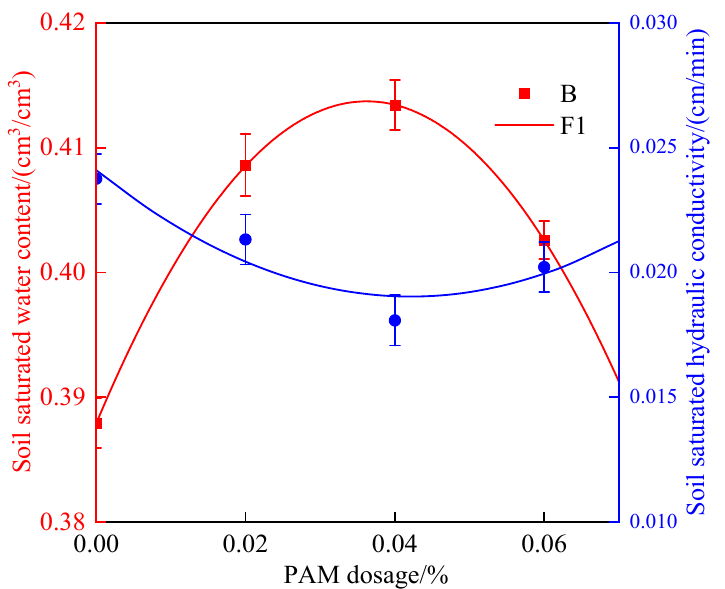
Figure 3. Effects of PAM dosages on soil saturated water content and saturated hydraulic conduc- tivity.